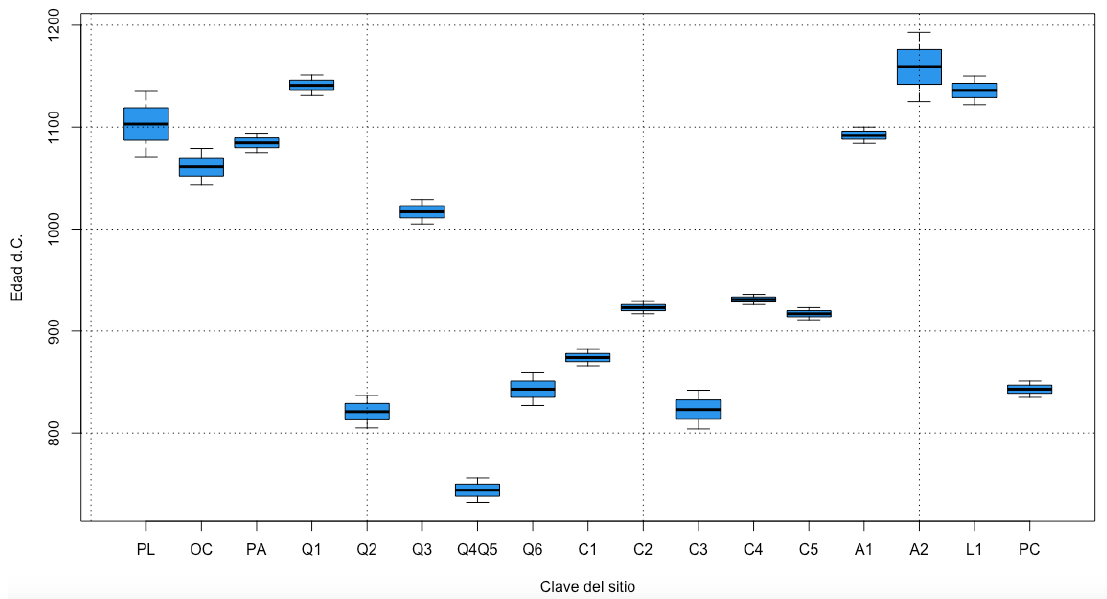
Figure 4. Age intervals for archaeological artifacts from sites located on the northern border of Mesoamerica calculated using the bootstrap method.